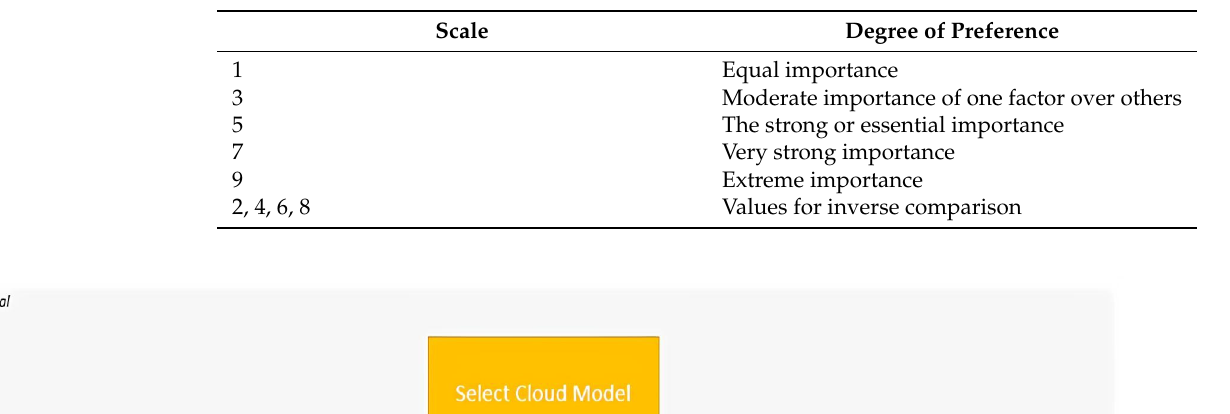
Table 7. Comparison scale [97].